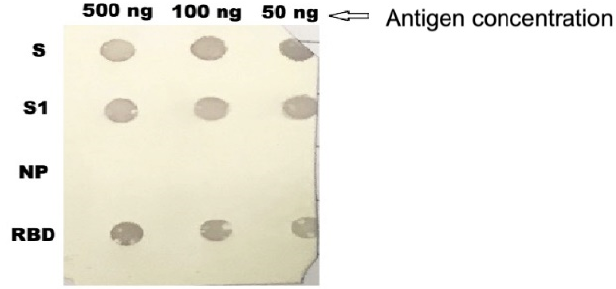
Figure 4. Dot blotting analysis. Purified anti-S1 IgY antibodies showed reactivity with different concentrations of the spike protein (S), S1, and receptor binding domain (RBD), but had no reactivity with nucleocapsid (NP) protein of MERS CoV.